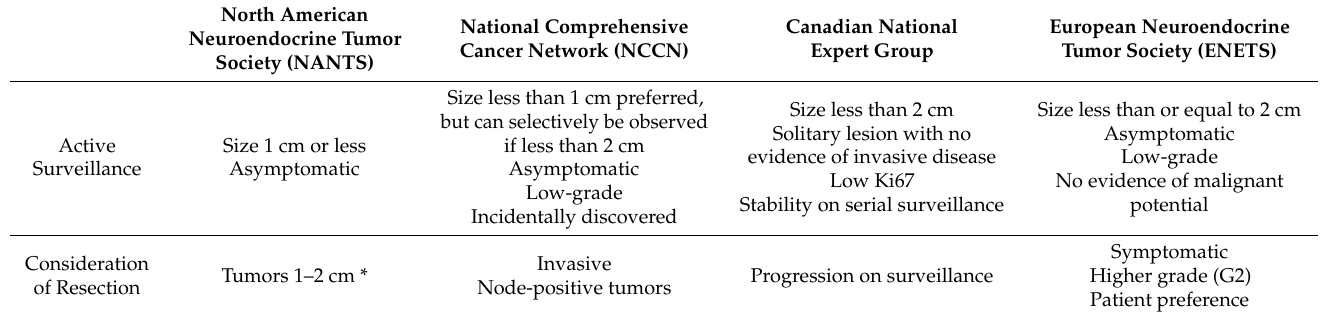
Table 3. Comparison of society recommendations for management of small nonfunctional